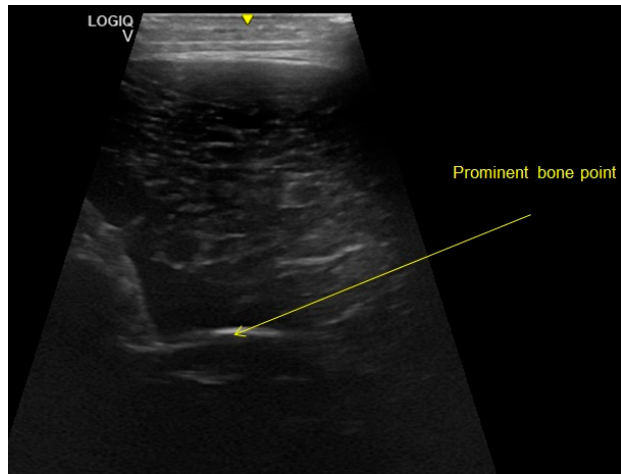
Figure 3. Ultrasound image taken in these examinations in order to illustrate the prominent bone point (photo: © Reckels, University of Veterinary Medicine, Hanover).